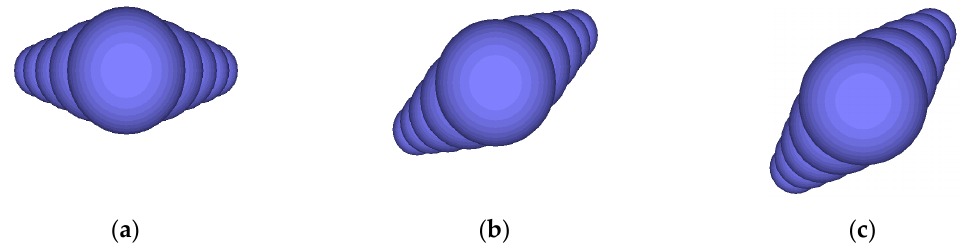
Figure 14. Ellipsoidal aggregates with different orientations: ( a ) 0°; ( b ) 30°; ( c ) 45°.